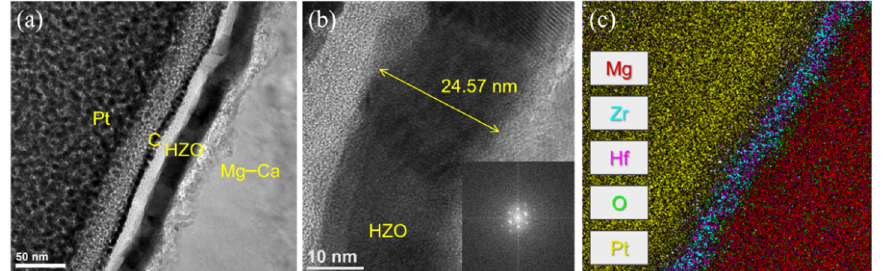
Figure 3. Cross-sectional TEM images of HZO(200 cycles)/Mg–Ca at magnification of ( a ) 64,000× and ( b ) 440,000×. The inset of ( b ) is the diffraction pattern of the central region calculated by FFT. ( c ) The corresponding EDS mapping results of ( a ). The text colors listed on the left of ( c ) correspond to the colors in the diagram.